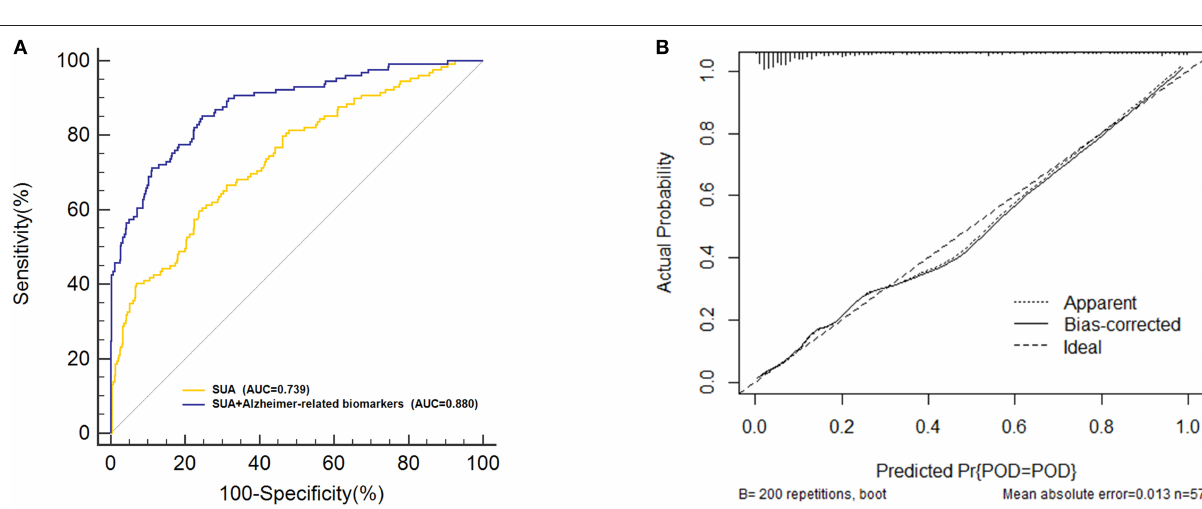
FIGURE 6 | Predictive model. (A) The model combining serum uric acid (SUA) and the Alzheimer-related biomarkers [area under the curve (AUC) = 0.880; p < 0.001] exhibited a relative better discriminatory ability in postoperative delirium (POD) prediction compared to only SUA (AUC = 0.739; p < 0.001). (B) Calibration curve demonstrated the effectiveness of the predictive